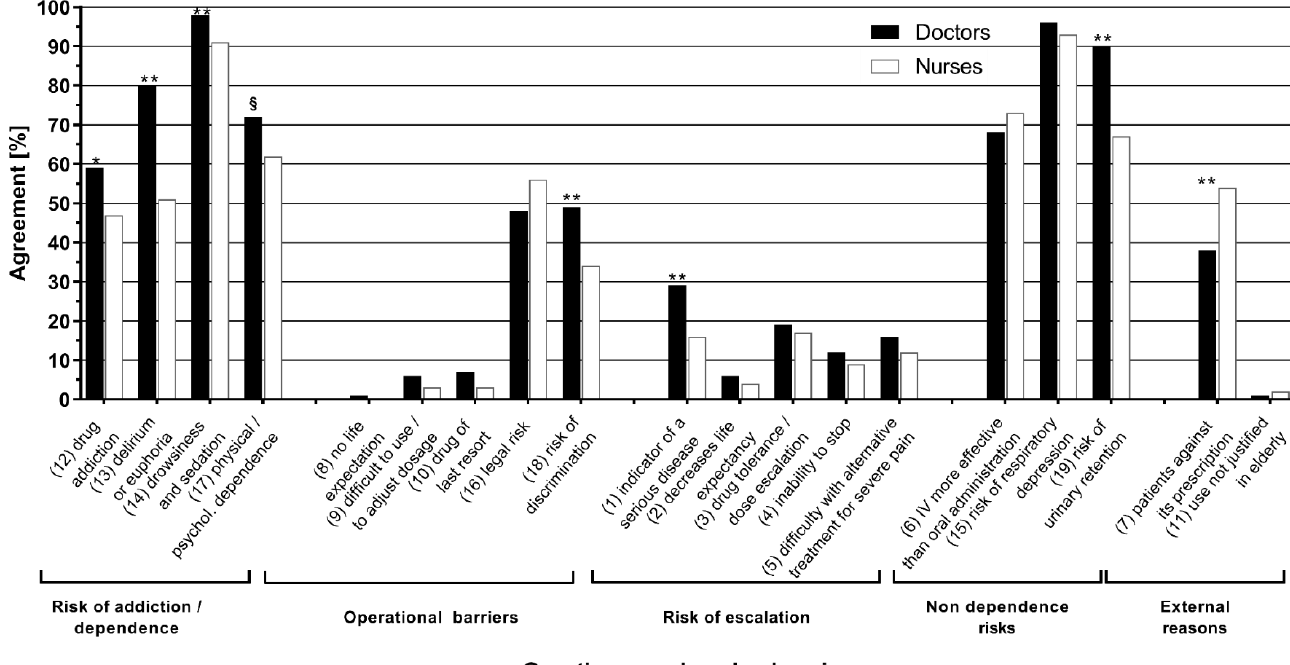
Figure 1. Percentage of agreement for each dichotomized item of the “Attitude Towards Morphine Score” grouped by profession and subscale. Agreement corresponds to the values of 1 and 2 of the Likert scale (i.e., Totally Agree or Agree); *: p <0.01; **: p ≤ 0.001; §: p < 0.05 for comparisons between MDs et RNs. Numbers in brackets refer to the question numbers in the Appendix A.